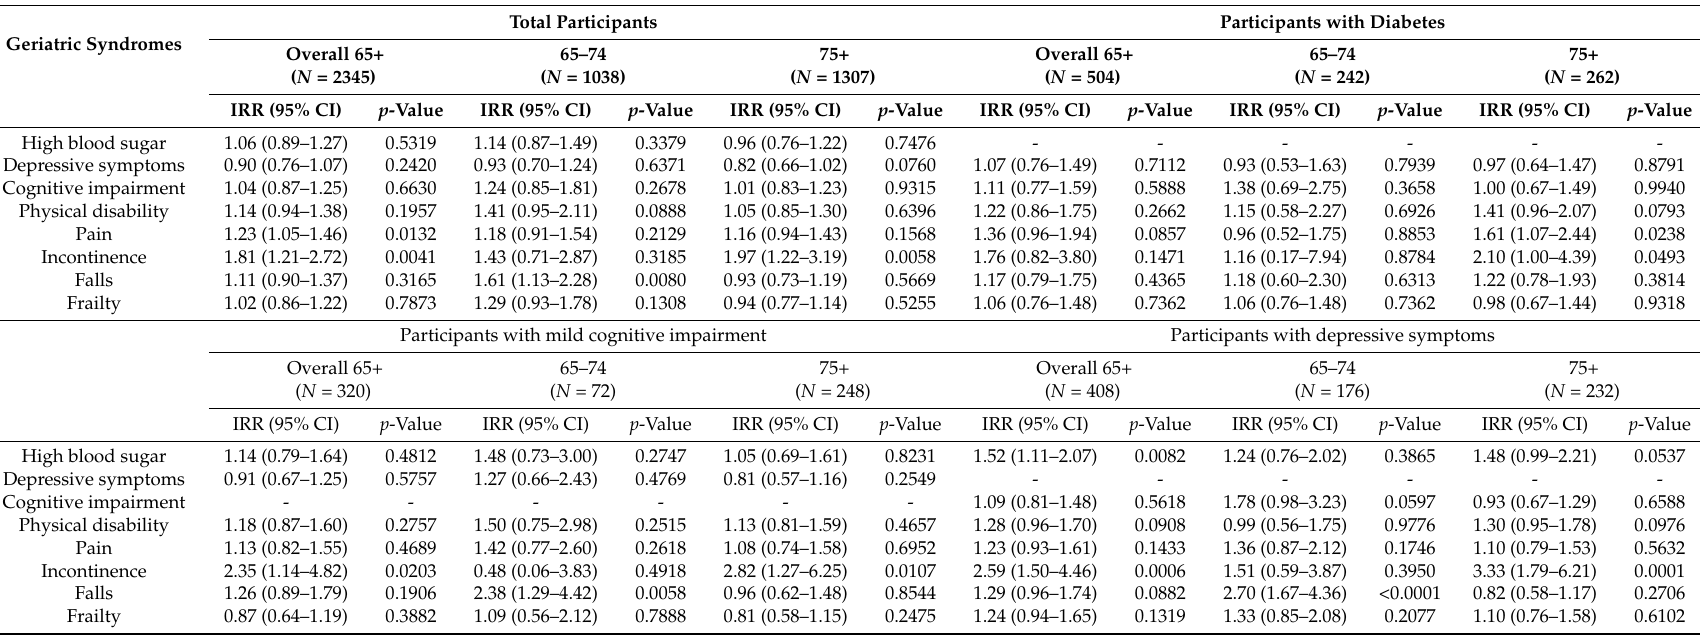
Table 5. Individual effects of geriatric syndrome indicators on number of